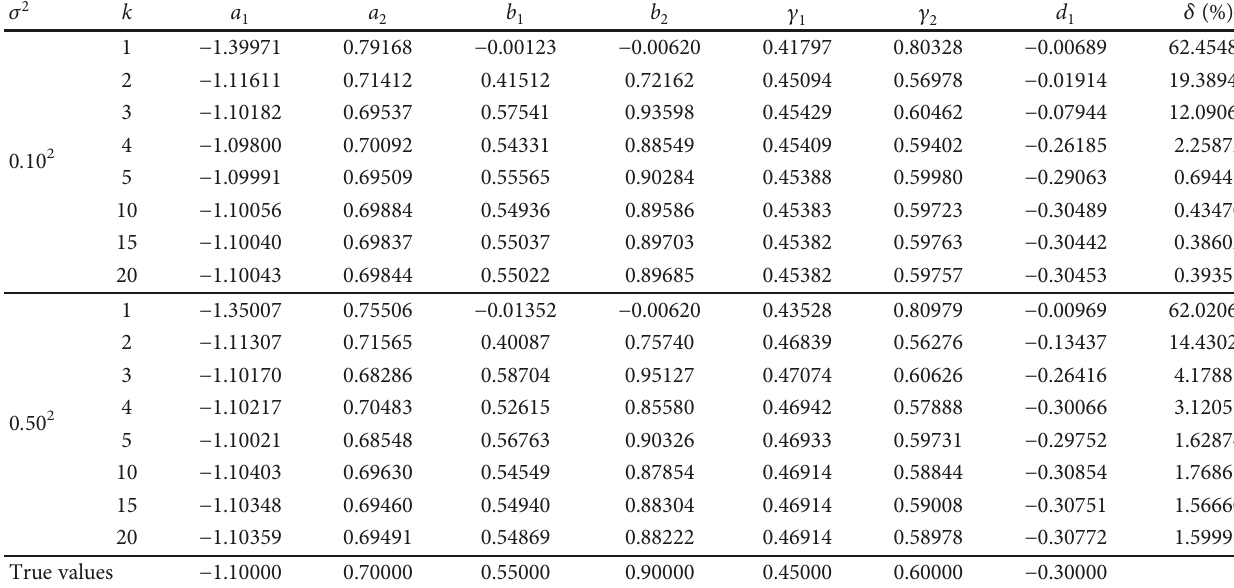
Table 2: The parameter estimates and errors of the KT-NI algorithm.